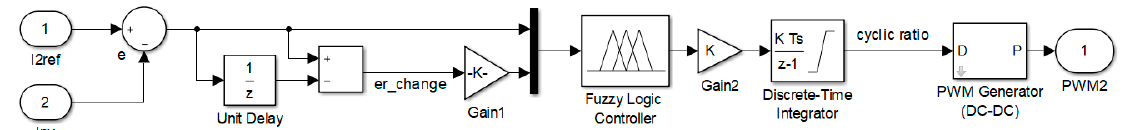
Appl. Sci. 2021 , 11 , x FOR PEER REVIEW Figure 9. Diagram of the fuzzy controller. Figure 9. Diagram of the fuzzy controller.